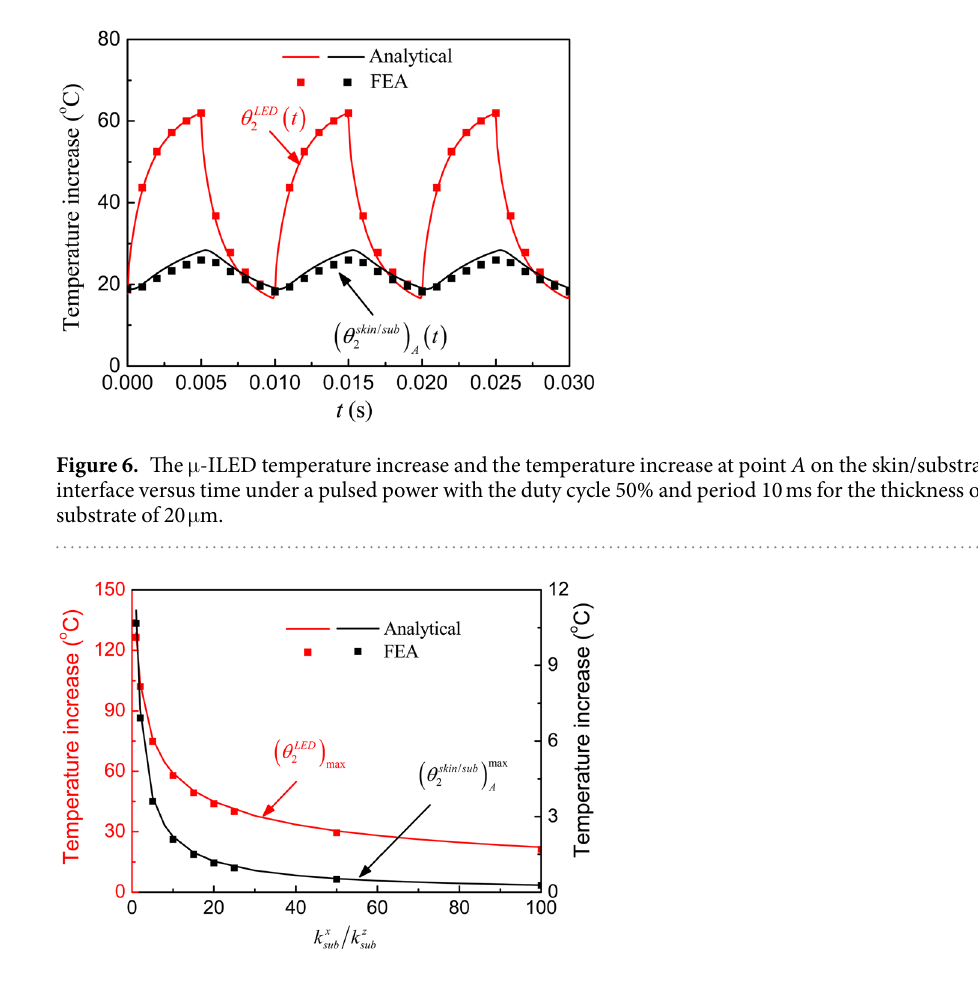
Figure 7. Effects of the orthotropic substrate on the maximum μ -ILED temperature increase and the maximum skin temperature increase under a pulsed power with the duty cycle 50% and period 10